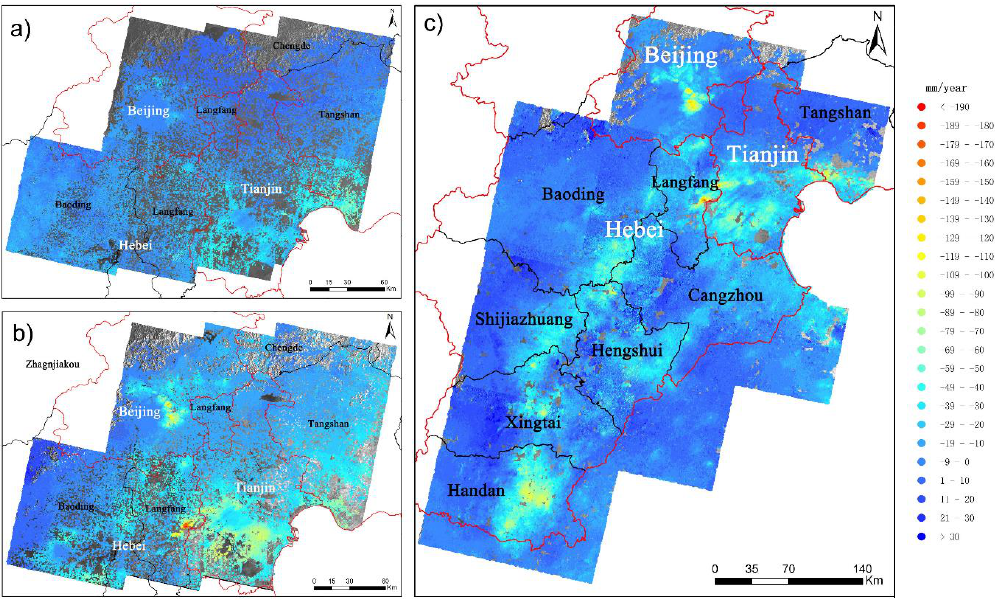
Figure 10. Ground subsidence rate in the key area of BTH: ( a ) ground subsidence during 1992 to 2002; ( b ) ground subsidence during 2003 to 2010; and ( c ) ground subsidence during 2012 to 2014.